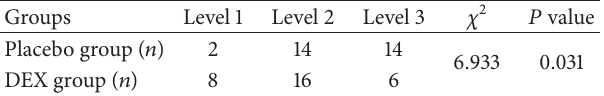
Table 2: The degree of adverse reactions of hemostatic stuffing after